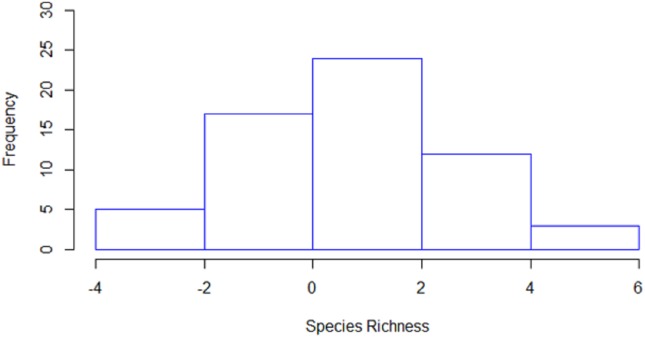
Histogram of the differences in estimated species richness by the line and strip transects methods.For the calculation, strip transect richness was subtracted from line transect.